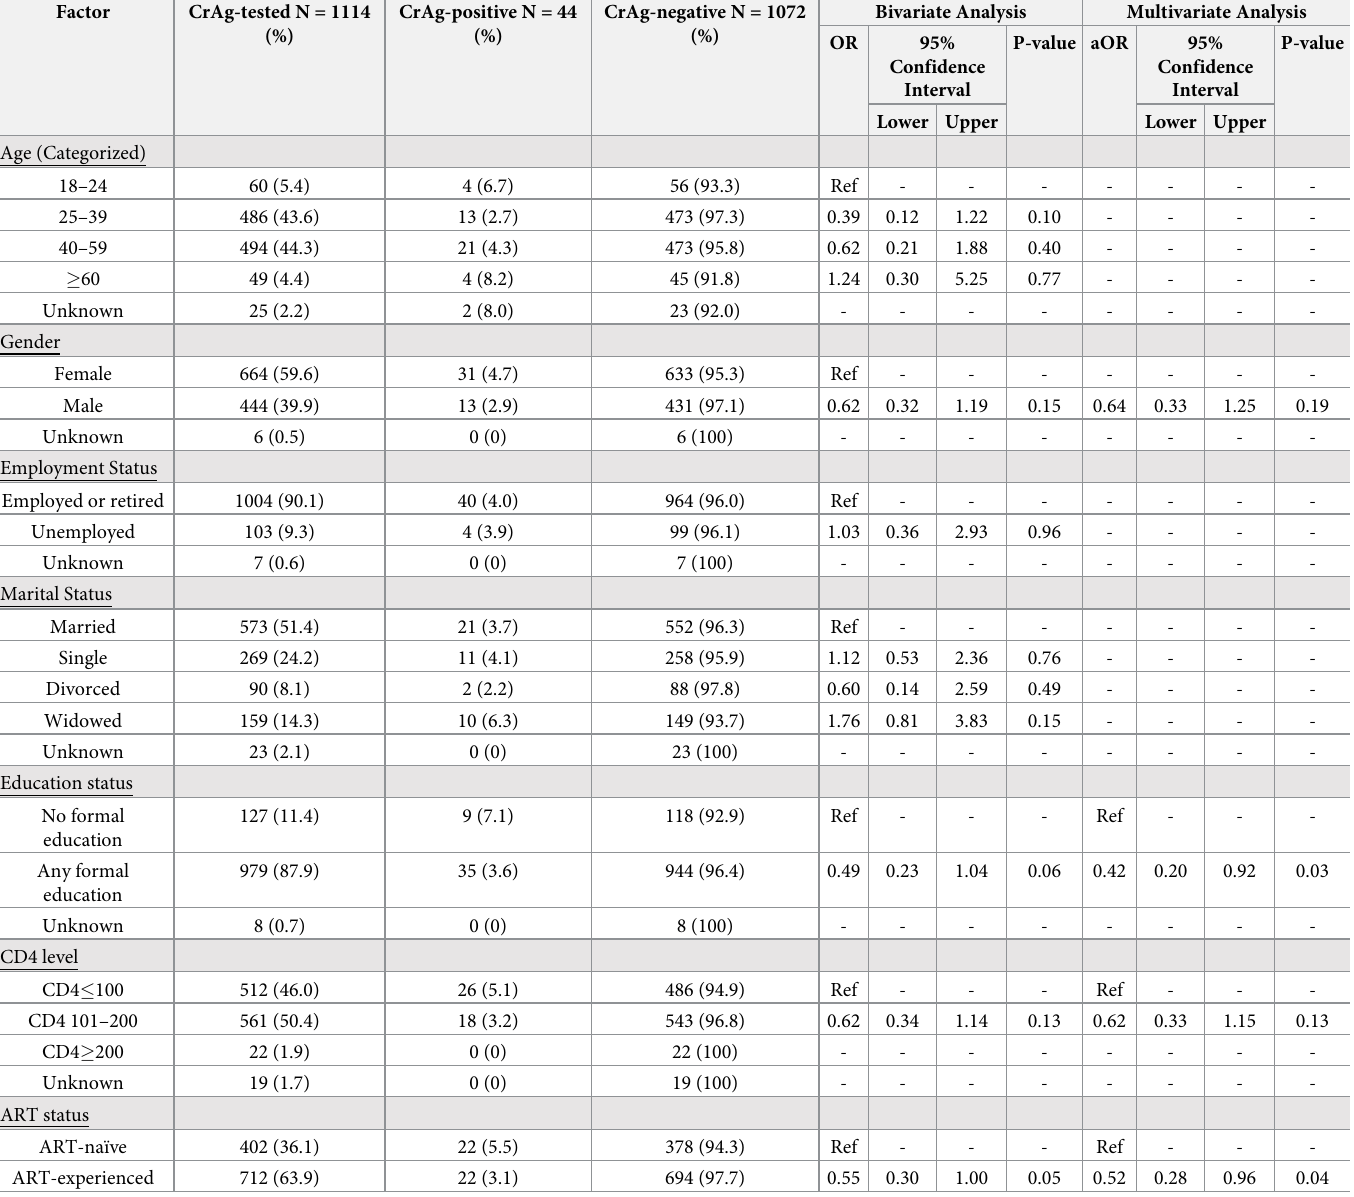
Table 3. Risk factors for cryptococcal